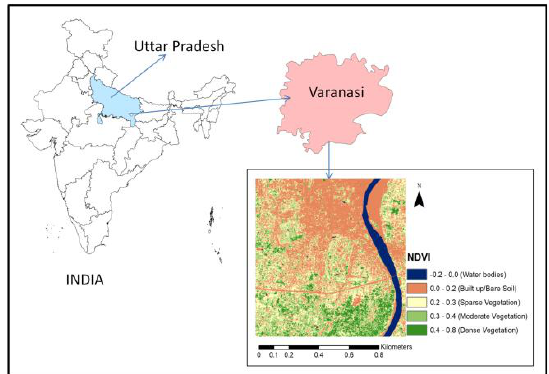
Figure1. Location of study area (Landsat-8 satellite data).